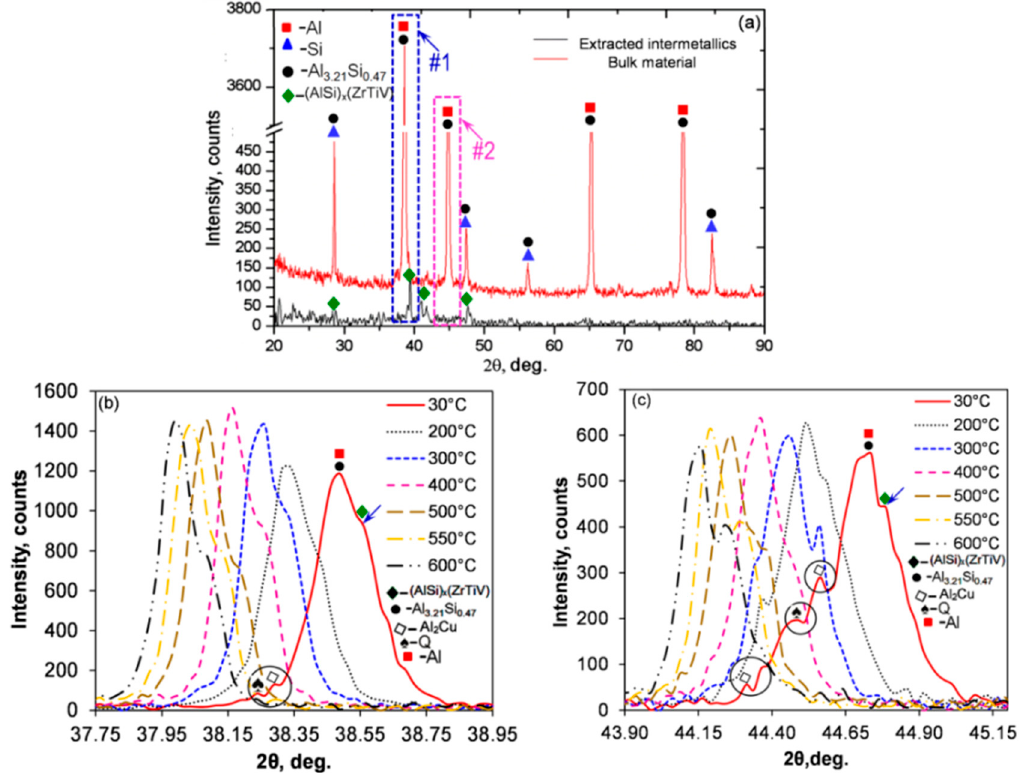
Figure 12. An application of high-temperature X-ray di ff raction for thermal stability testing of phases in as-cast Al–7Si–1Cu–0.5 Mg alloy with 0.21Ti, 0.3V, and 0.47Zr (wt.%): ( a ) room temperature di ff raction patterns obtained from bulk materials and extracted intermetallics; ( b , c ) di ff raction patterns at 2 θ locations for peaks #1 and #2 at temperatures from 30 to 600 ◦ C. The experiment was conducted with Cu K α radiation at 45 kV and 40 mA, with a step size of 0.05 deg, and duration of 0.2 s for each step [49].